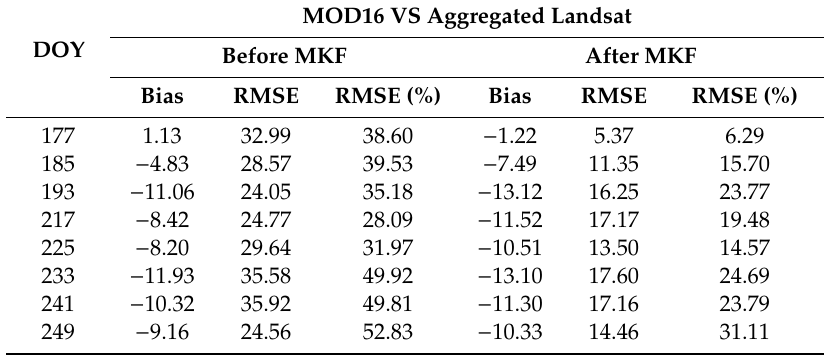
Table 2. Statistical comparison of the assessment criteria before and after MKF. MOD16 VS Aggregated DOY